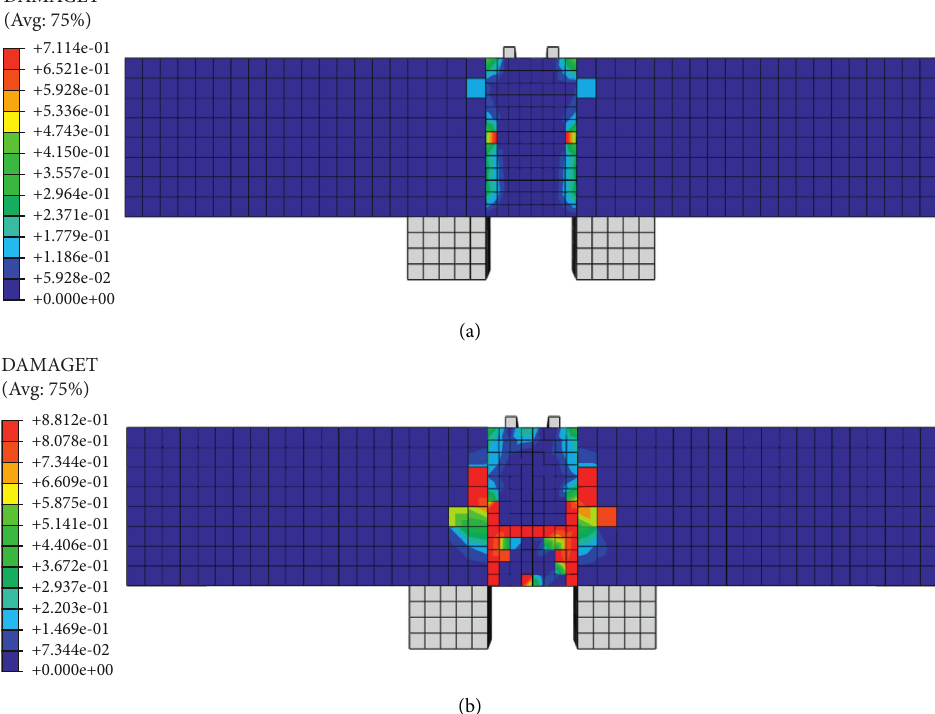
Figure 19: Cracking patterns of Type 2. (a) Initial interface cracking. (b) Cracking patterns at